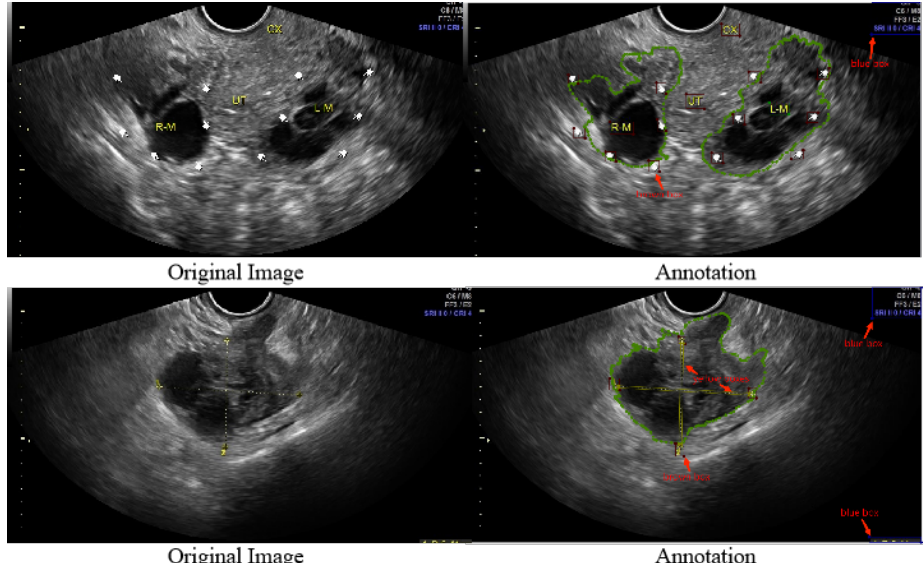
Figure 3. Original 2D ovarian-tumor ultrasound images and images with annotated symbols.